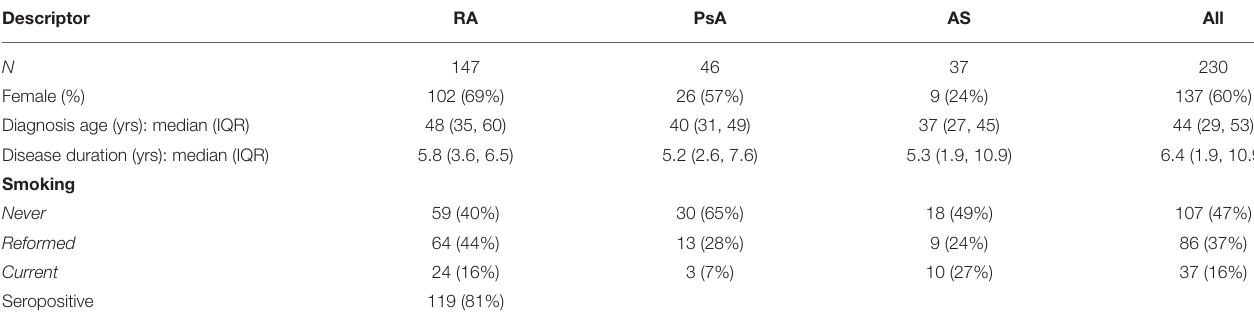
TABLE 1 | Baseline demographics (at the time of the first b/tsDMARD) for rheumatoid arthritis (RA), psoriatic arthritis (PsA) and ankylosing spondylitis (AS) patients.